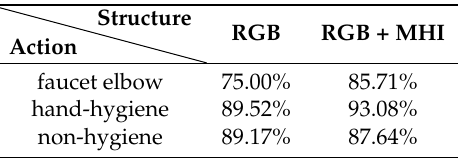
Table 5. Coarse wall classifier: Performance of RGB and RGB + MHI between 3 actions at unit-level, both RGB and RGB + MHI use 5 groups of convolutional layers and 1 fc layer